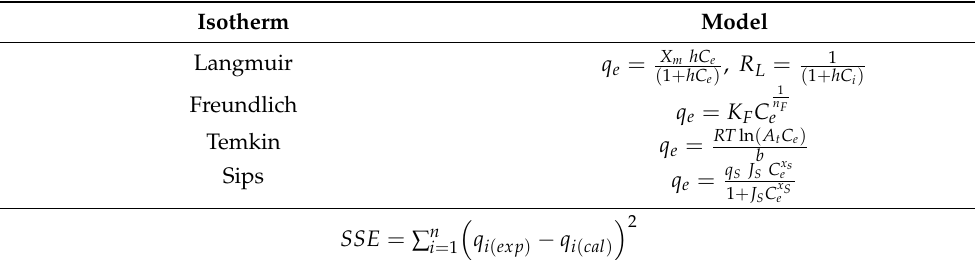
Table 3. Adsorption isotherm models and SSE equation.